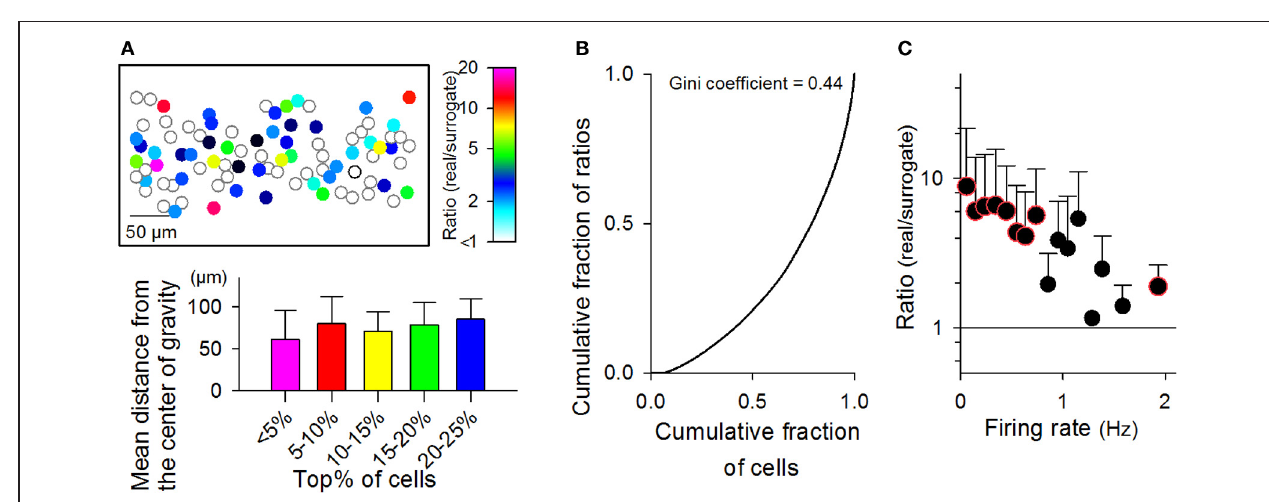
FIGURE 10 | Relationship between the firing rates of neurons and their MSS participations. (A) Top: a cell map representing the number of individual cells participating in MSSs during the observation period. Data are shown as the ratio of the real rastergrams to their randomized controls. Bottom: The mean Euclidean distance to the center of gravity from individual cells with the highest x % of the real-to-surrogate ratio. The ranges of x values are indicated in the abscissa. For example, in the case of 5–10%, we selected cells with the real-to-surrogate ratios that ranged from the top 5 to the top 10%, calculated the center of gravity of those selected cells, and measured the mean distance from those cells to their center of gravity. (B) A Lorenz curve representing the proportion of real-to-surrogate ratios assumed